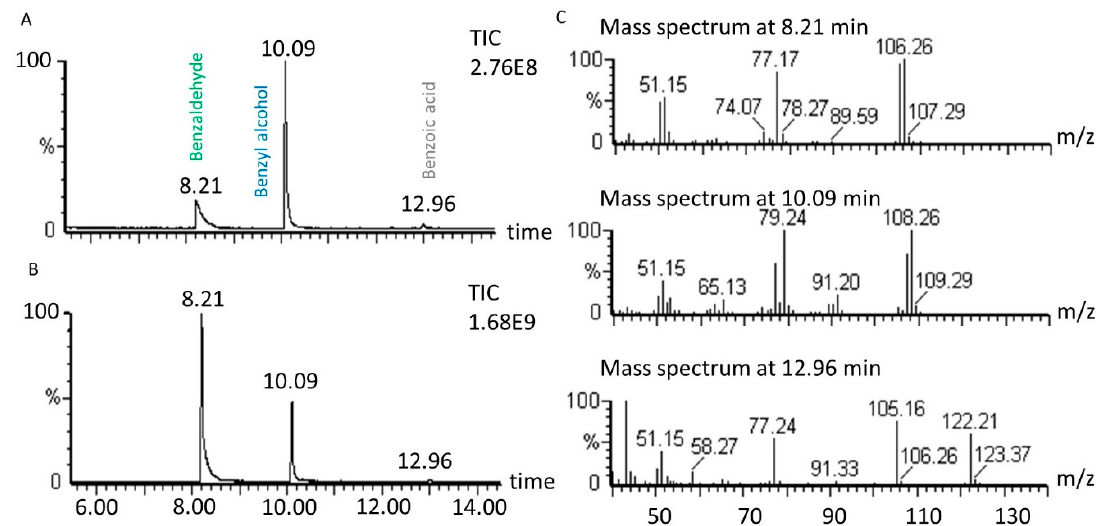
Figure 9. Oxidation of benzyl alcohol GC chromatogram ( A ) in silent conditions and ( B ) under US irradiation. ( C ) mass spectra of identified peaks obtained by electronic impact (70 eV). Reaction conditions under 20 kHz and silent conditions; 571 mM PhCH 2 OH, 1 molar equivalent of H 2 O 2 , 1% molar equivalent of catalyst, 5.61 mL H 2 O, 70 °C, 90 min. Silent conditions: Argon bubbling; US conditions: 20 kHz, P acous = 47.9 W L − 1 h − 1 , 13 mm probe.